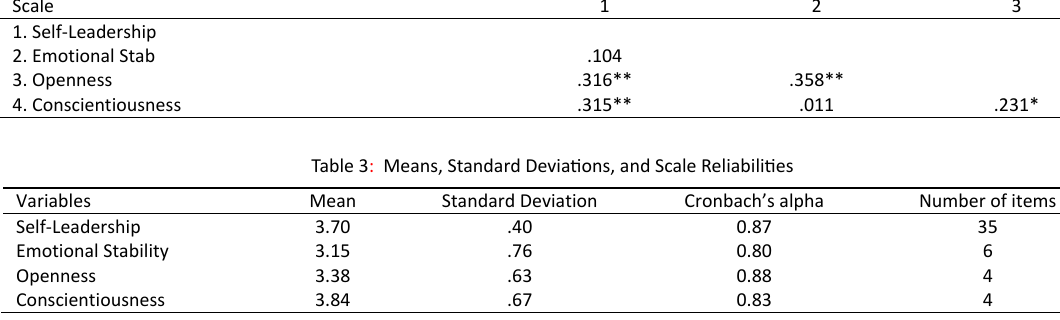
Table 2: Pearson Product-Moment Correlations between variables Scale